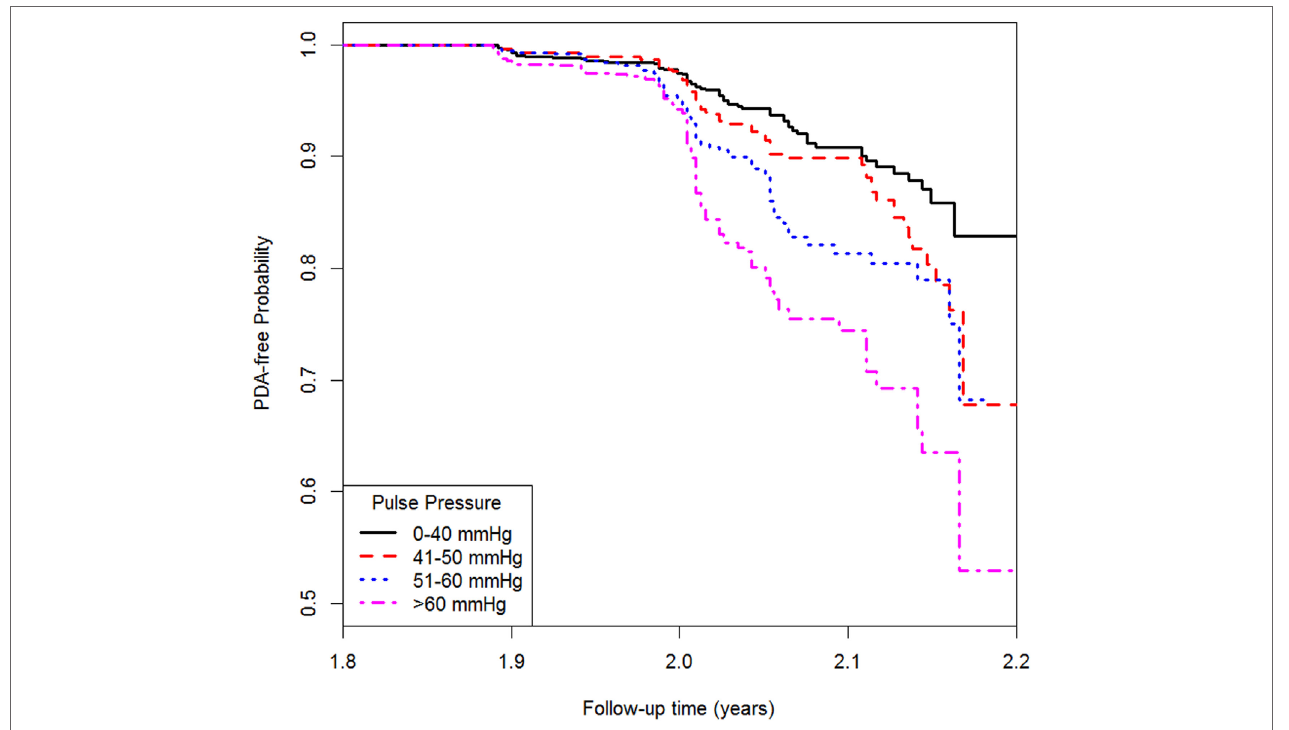
FigUre 1 | Kaplan–Meier plot for peripheral arterial disease by pulse